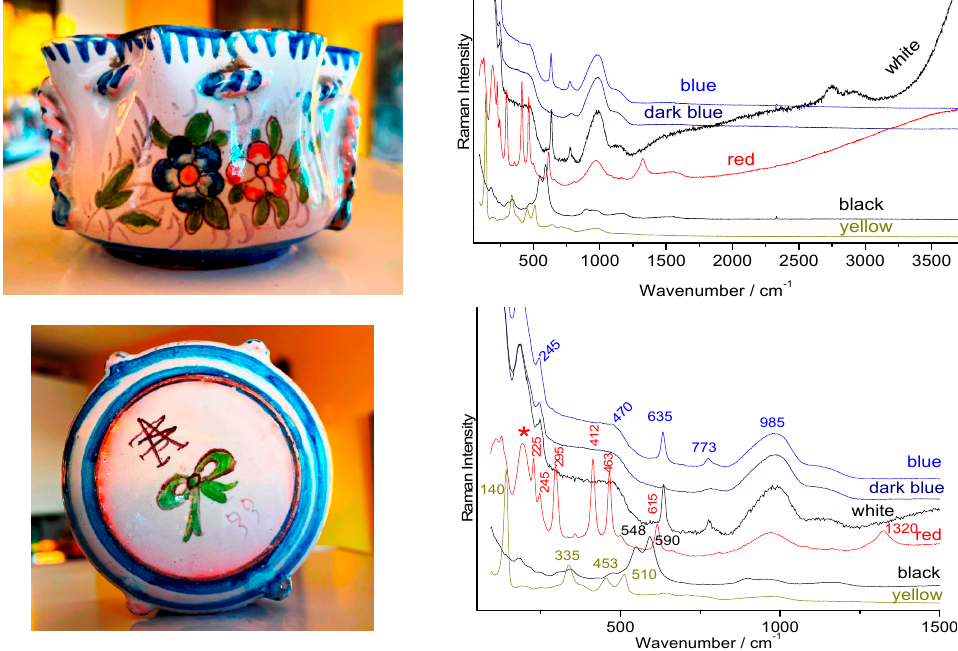
Figure 11. ( A , B ) Raman spectra representative of the decoration of a British faience (W. Brownfield factory, see Figure 2f), on the left zoom of the spectral domain characteristic of the fundamental modes; ( C ) photography and ( D ) Raman spectra of a Chinese necklace representative of enamel on copper with enameled pendant (Canton, Figure 2e); colored areas examined are given. Band with a * arise from the filter.